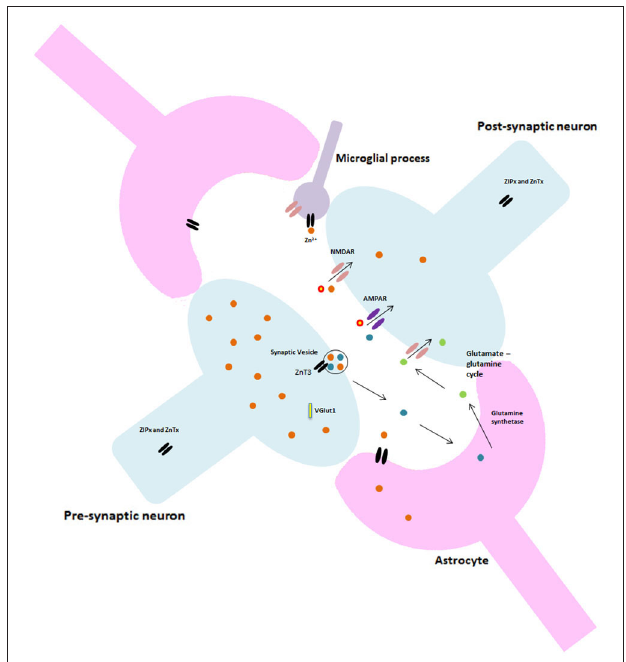
FIGURE 3 | Neuron-glia and zinc synaptic interactions in (A) normal, (B) aged, and (C) Alzheimer’s disease